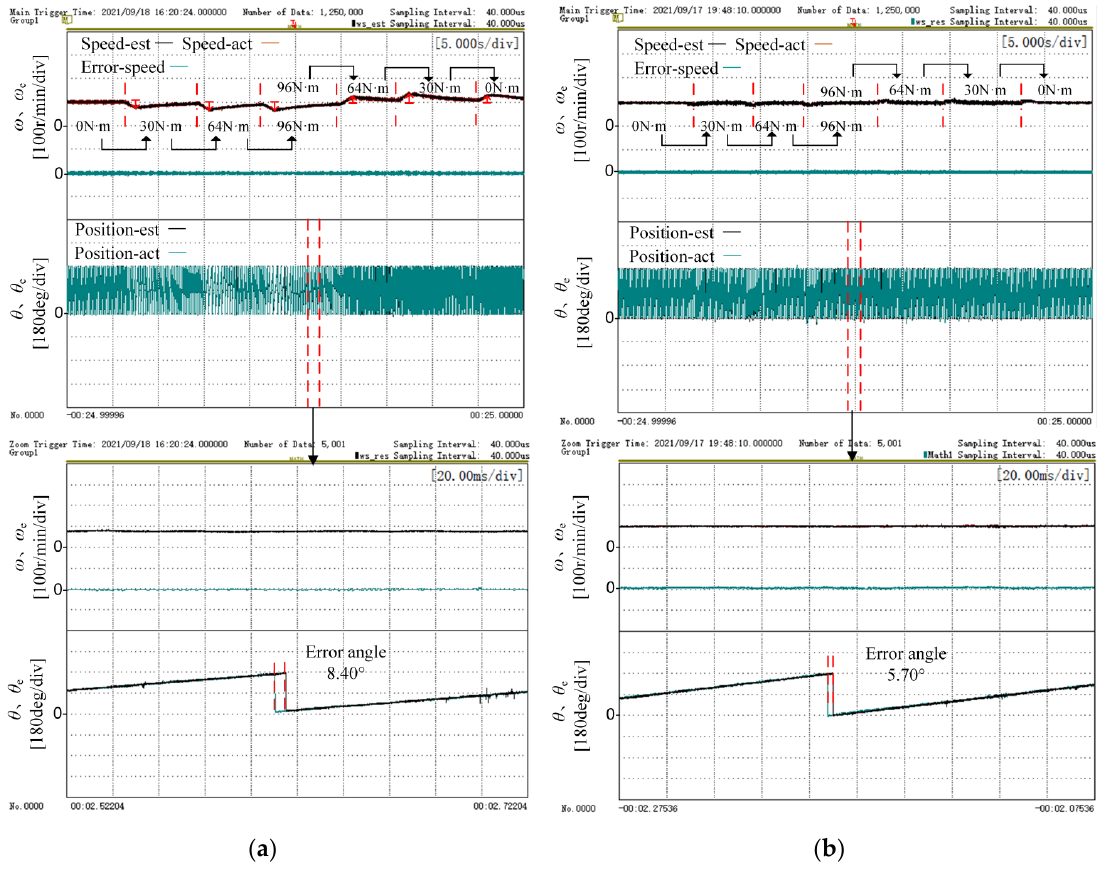
Figure 16. The speed control of tested motor with traditional method and proposed method at 100 r/min: ( a ) traditional method; ( b ) the proposed method.